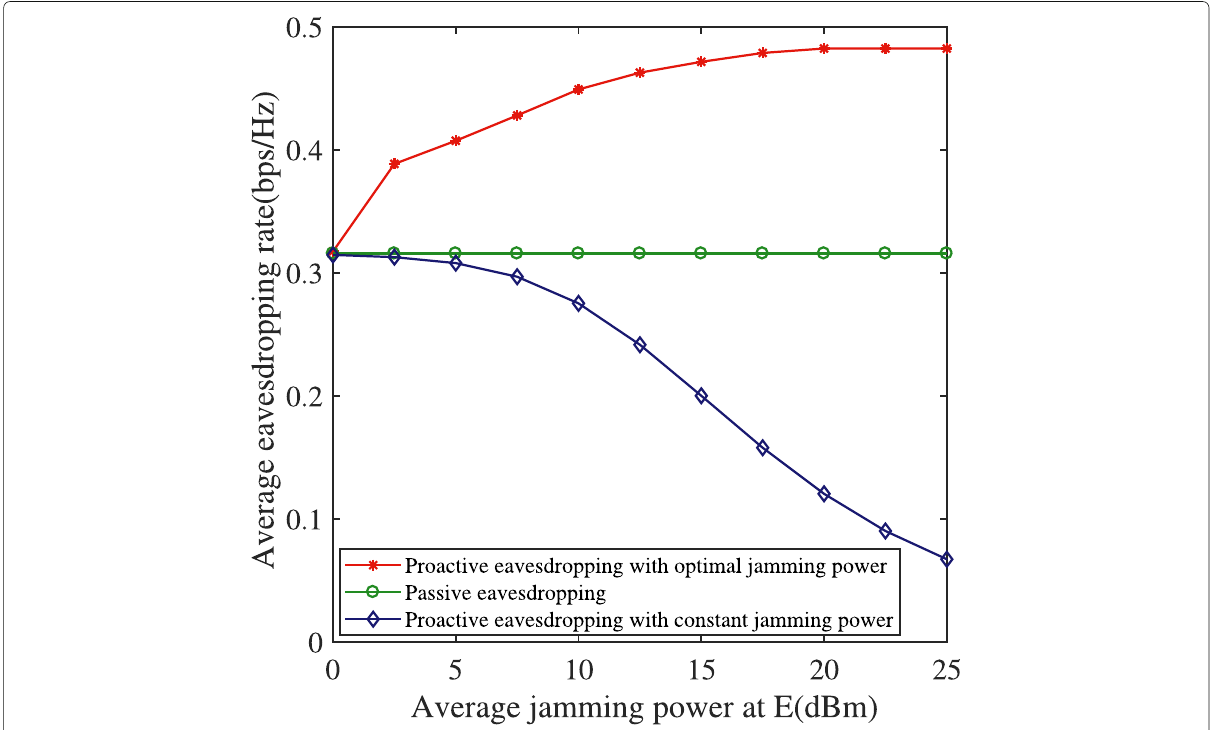
Fig. 2 Eavesdropping rate versus average jamming power ¯ Q for AF relaying